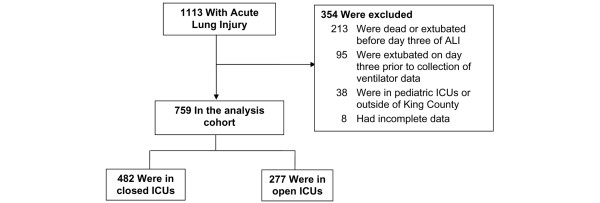
Cohort flowchart. ALI = acute lung injury; ICU = intensive care unit.